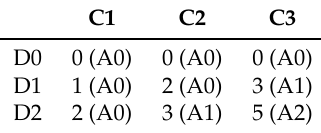
Table 2. Scores and maintenance levels (in brackets) attributed to each entry of the check lists to be used for each product, depending on the level of damage and the class of